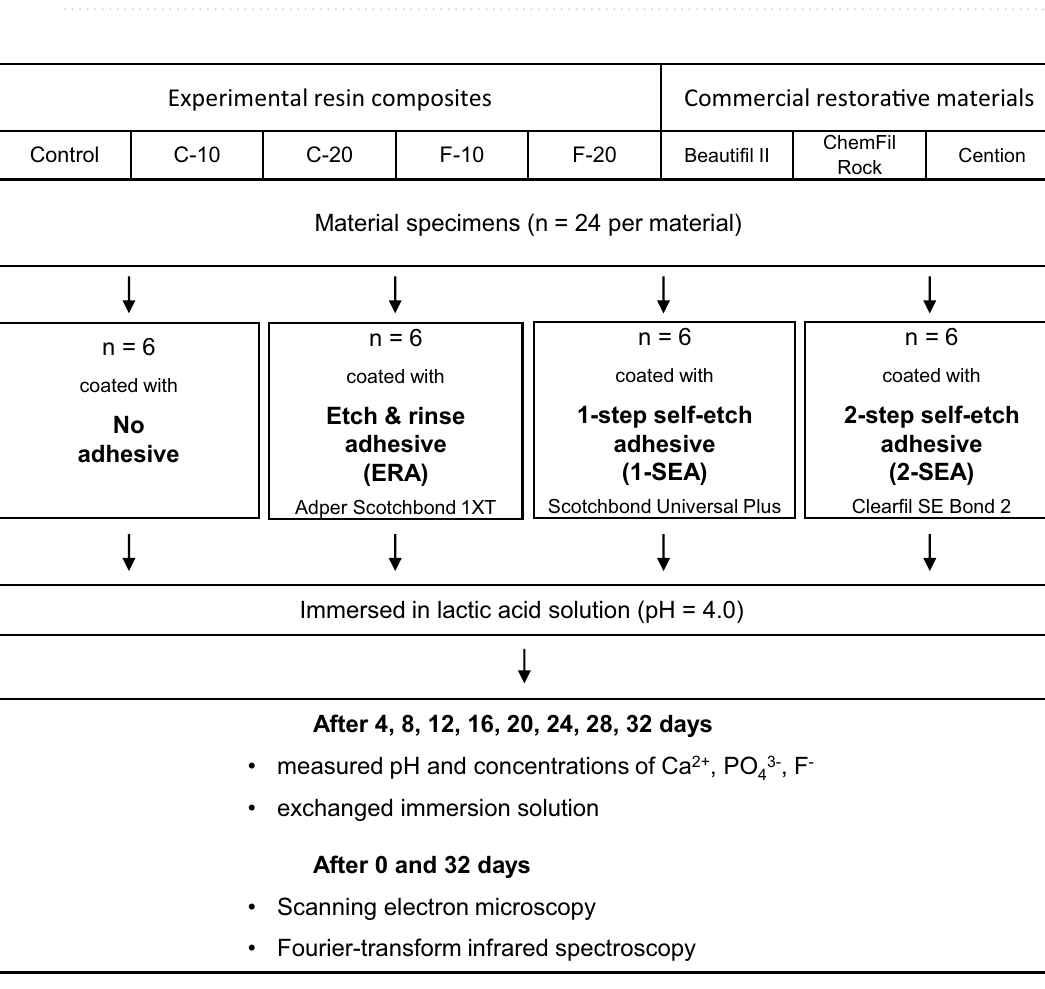
Figure 1. Flowchart of the study